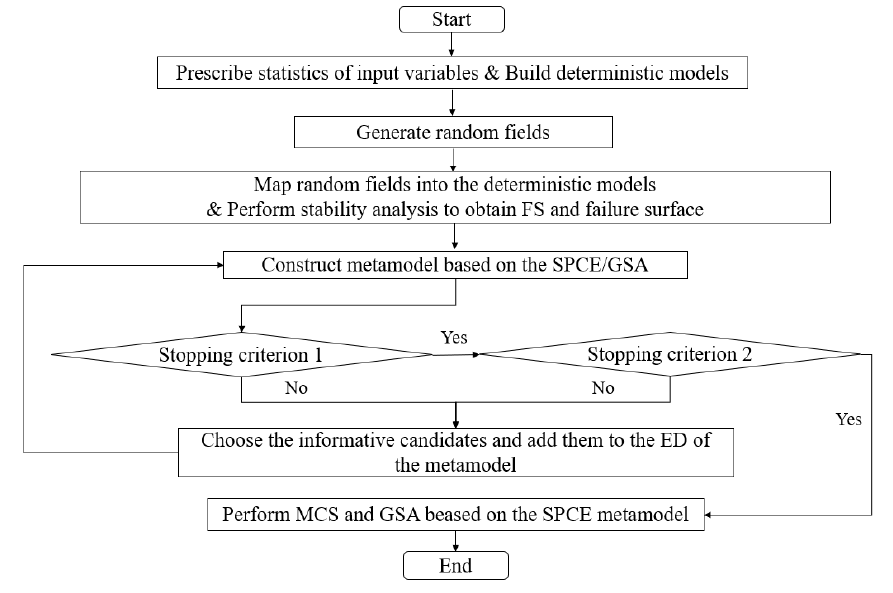
Figure 4. Flowchart of the analysis procedure D(F)SG–MG.